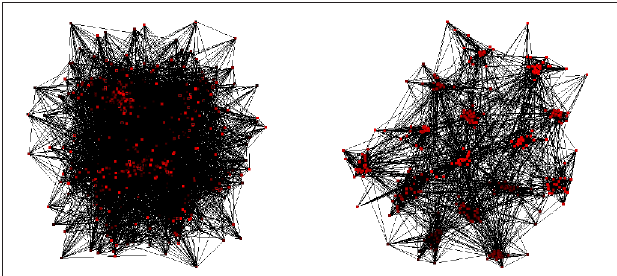
FIGURE 1 | Adaptive rewiring leads from an initial random network (left), to modular small-world structure (right) in small iterative steps. Coupled chaotic oscillators intermittently synchronize and desynchronize their activity spontaneously in patterns of great variability. After some time a momentarily synchronized pair of units that are not connected receive a connection, which is removed from a pair that are connected but not synchronized. As this process continues, a modular, small-world structure emerges from an initially random configuration. To obtain a more detailed view of this phase transition, we use the adaptive rewiring scenario with coupled nonlinear maps (Kaneko, 1989) with initially randomly structured graphs, for a range of different numbers of vertices v : v = 300 , 400 , 500 ,... , 1000 vertices and numbers of edges E that differ by small steps of 20. For each combination of v , E , across four million iterations we measured the CC and the CPL every one thousand iterations, resulting in a 4000 point record for each of five runs. The maximum, minimum, and mean values of the last 2000 points in each run were averaged over the five runs as illustrated in Figure 3 .